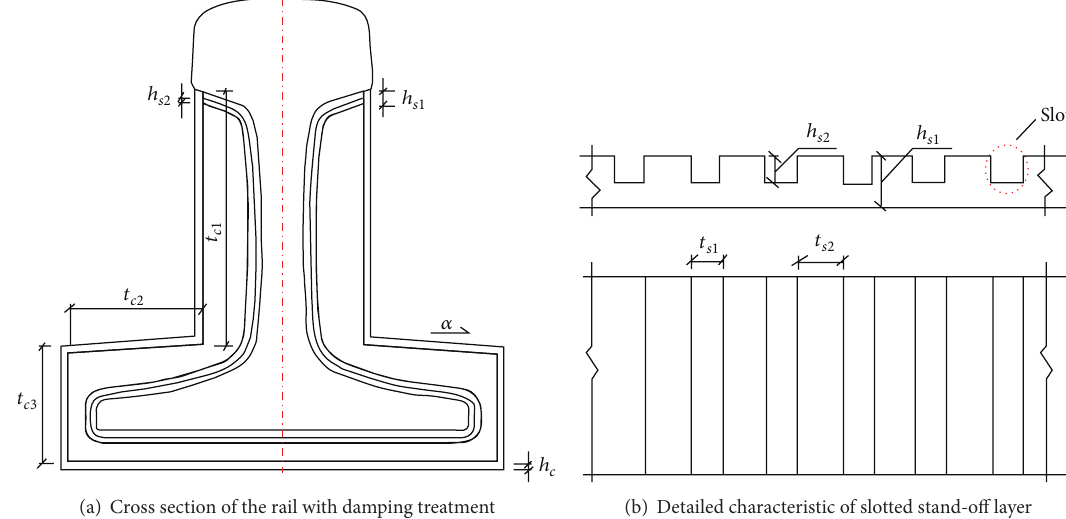
Figure 8: Parameter definitions of the slotted stand-off layer damping treatment.